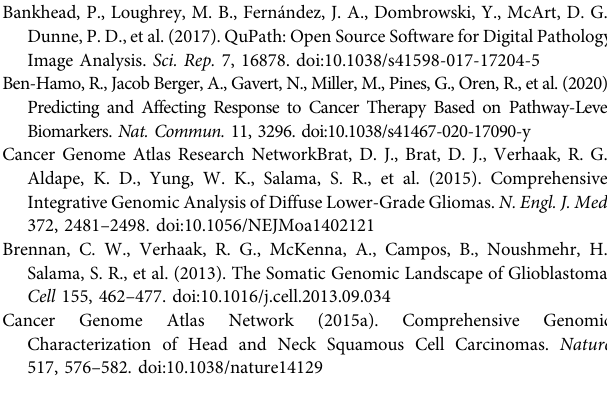
Supplementary Table S1 | Raw results (Microsoft Excel fi le) of all genes and grouping based on different data sources.